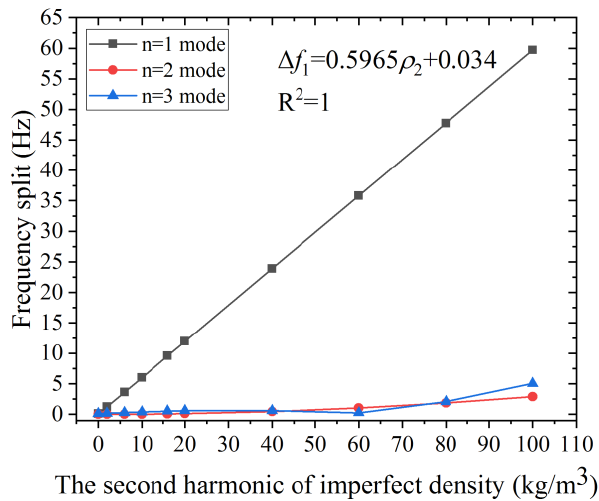
Figure 5. The effect of ρ 2 on the frequency split of the n = 1, 2, and 3 modes.